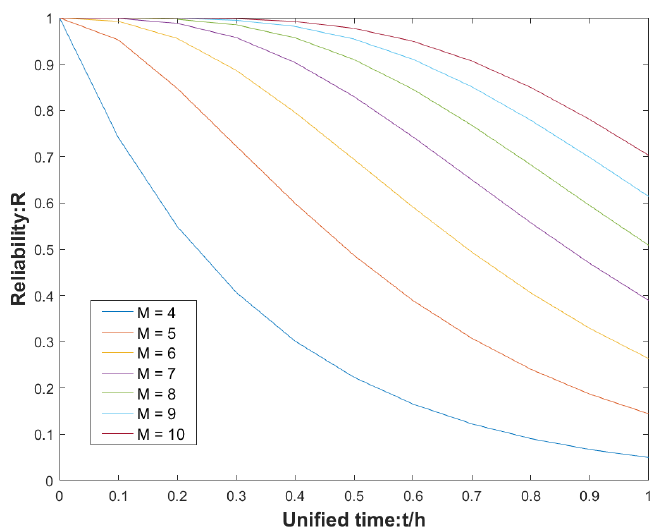
Figure 1. Reliability of a redundant system of three-axis inertial elements as a function of redundancy loss.